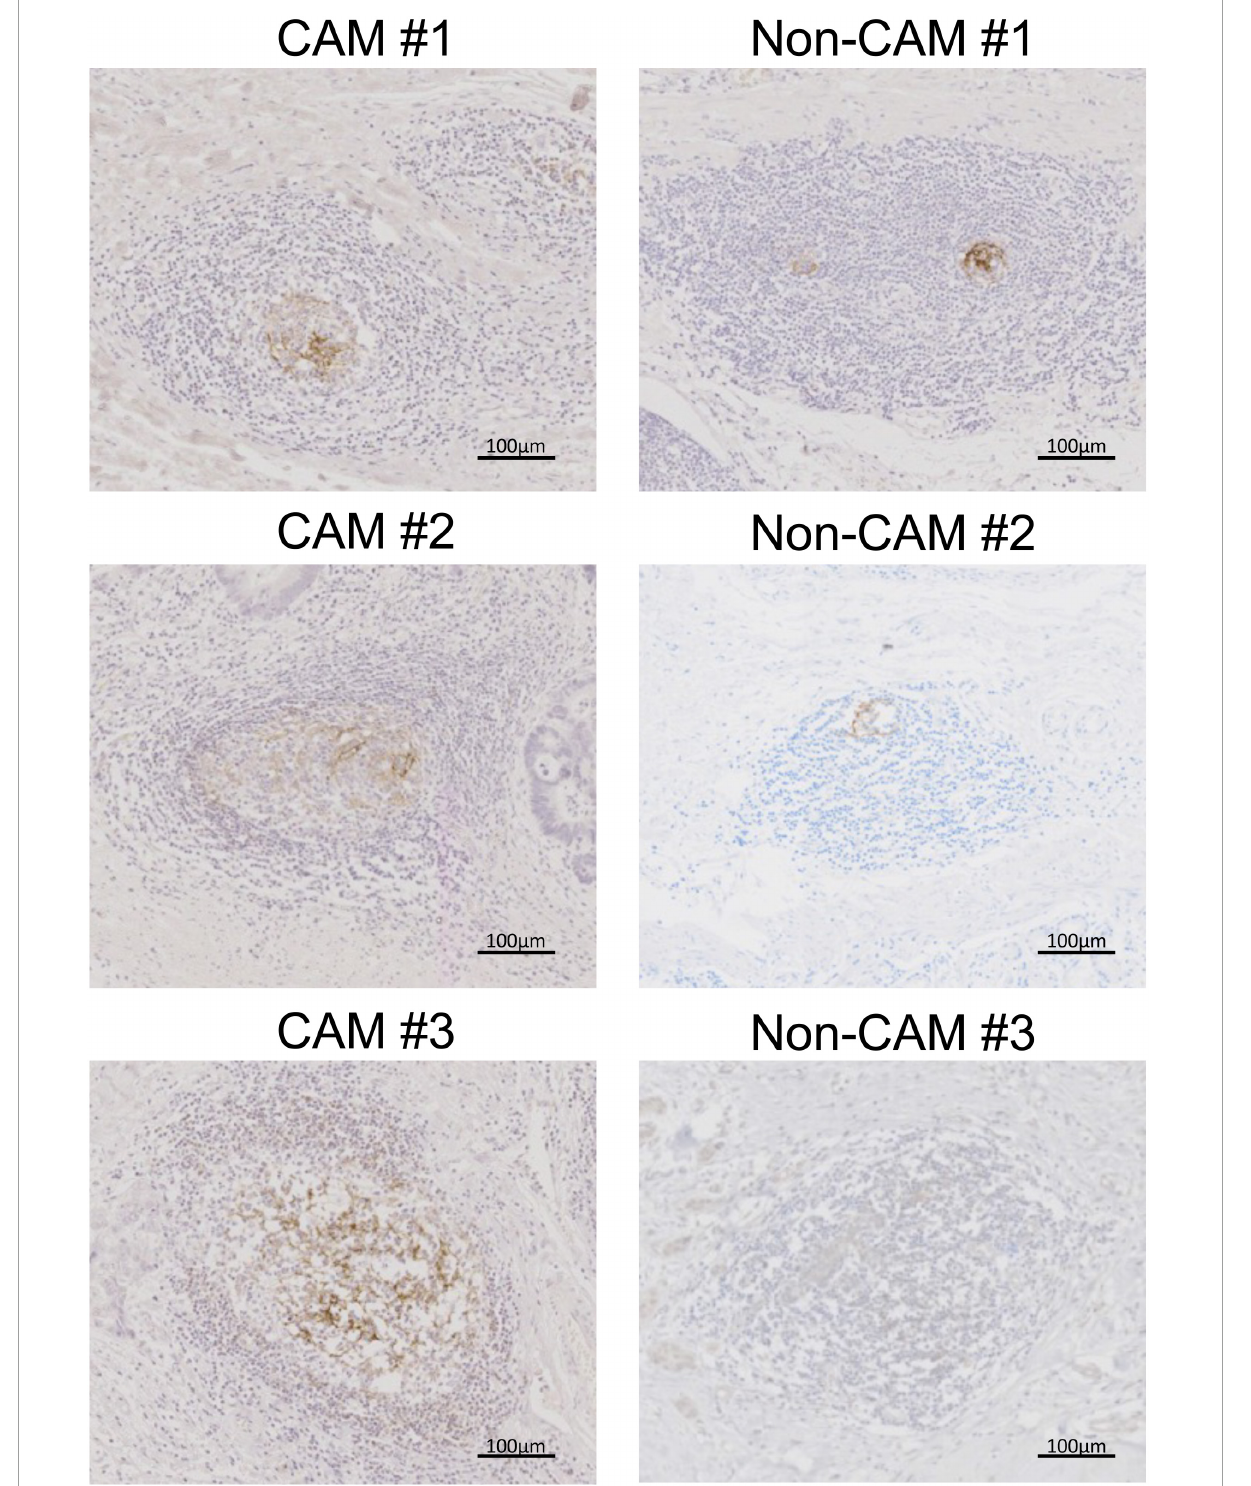
FIGURE6 CD23 + FDCs in TLSs from CAM patients and non-CAM controls. CD23 immunostaining was conducted in representative TLSs from 3 CAM patients (CAM #1-#3) and 3 non-CAM controls (non-CAM #1-#3). Scale bar = 100 µ m. FDCs, follicular dendric cells; TLSs, tertiary lymphoid structures; CAM, cancer-associated